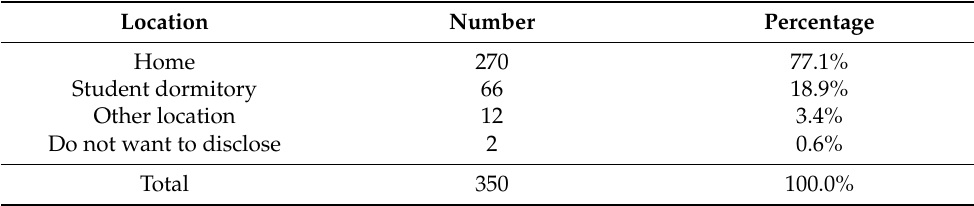
Table 5. Regular location of students without work